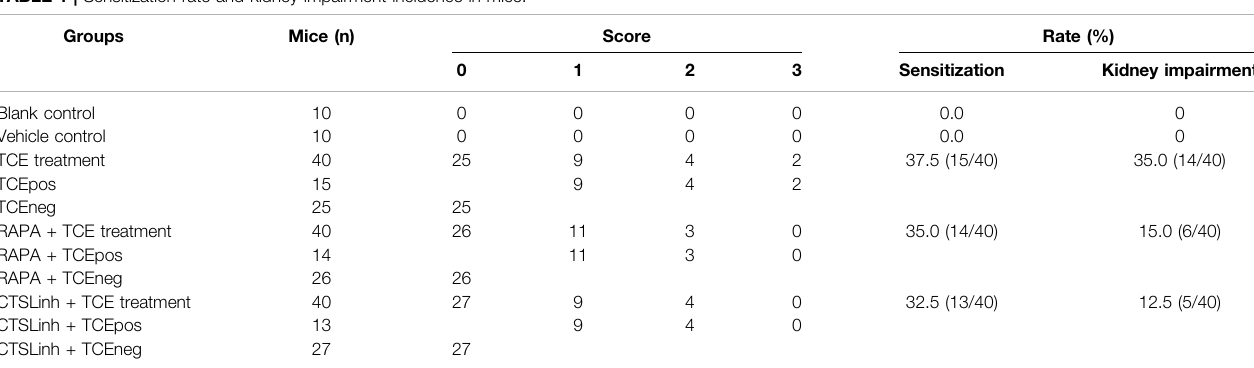
TABLE 1 | Sensitization rate and kidney impairment incidence in mice.